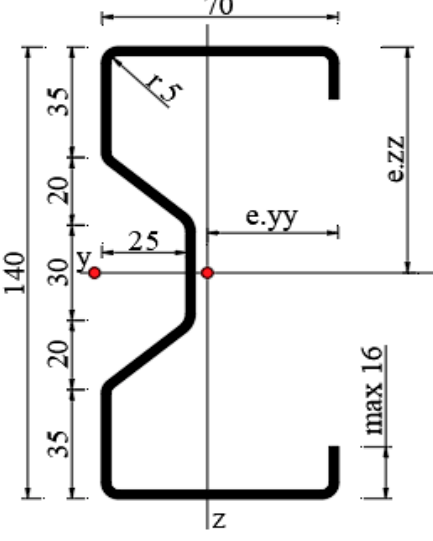
Figure 1. The Σ 140 × 70 × 2.5 cross-section geometry. Table 1. The geometrical characteristics of Σ 140 × 70 × 2.5 cross-section.